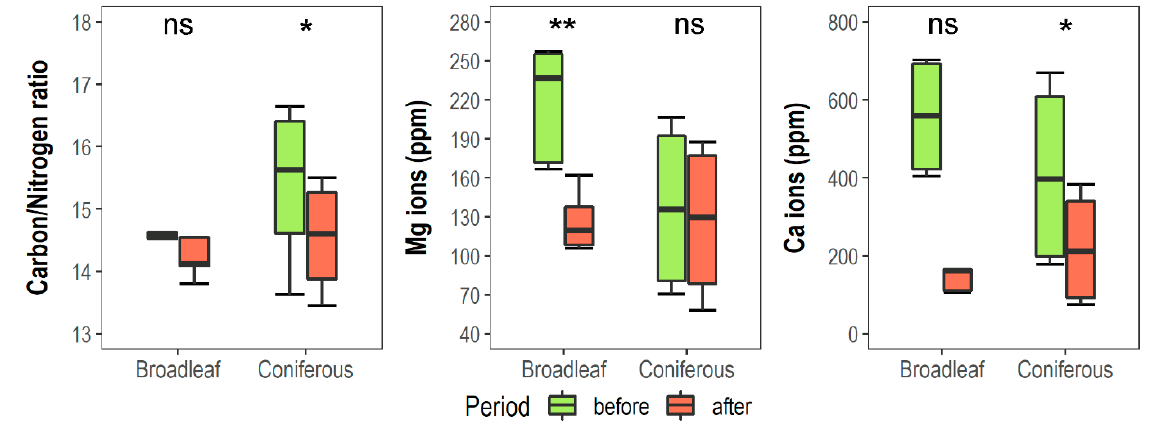
Figure 5. Differences in soil chemical variables between pre-disturbance (before typhoon) and post- disturbance (after typhoon) broadleaf and coniferous forests (36 permanent plots). The level of significance is indicated above the boxes: ns: non-significant; * p < 0.05; ** p < 0.01.